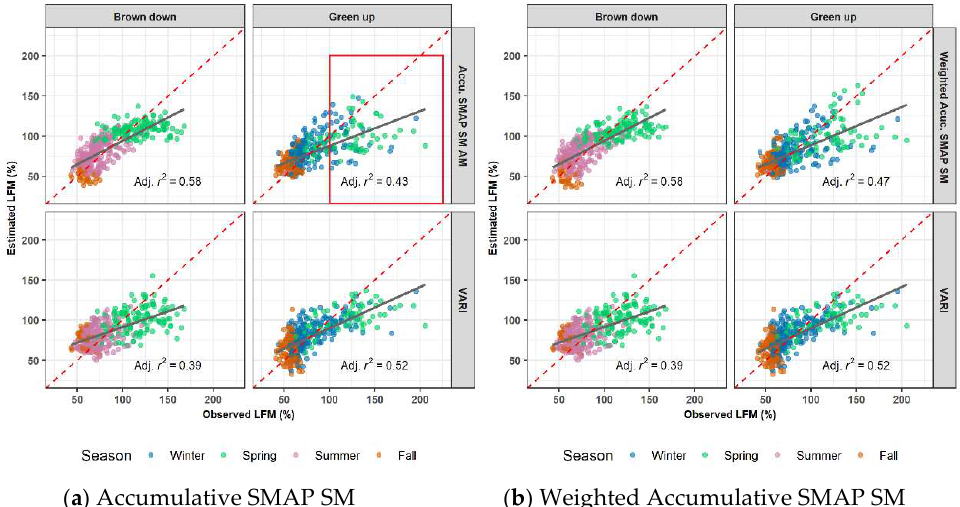
Figure 8. Observed LFM and estimated LFM using accumulative SMAP SM and CGDD ( a ) and weighted accumulative SMAP SM and CGDD ( b ). The brown-down and green-up periods were modeled separately. Outcomes from the VARI-only model were used for comparison. Coloring of data follows the same color code as Figure 7.